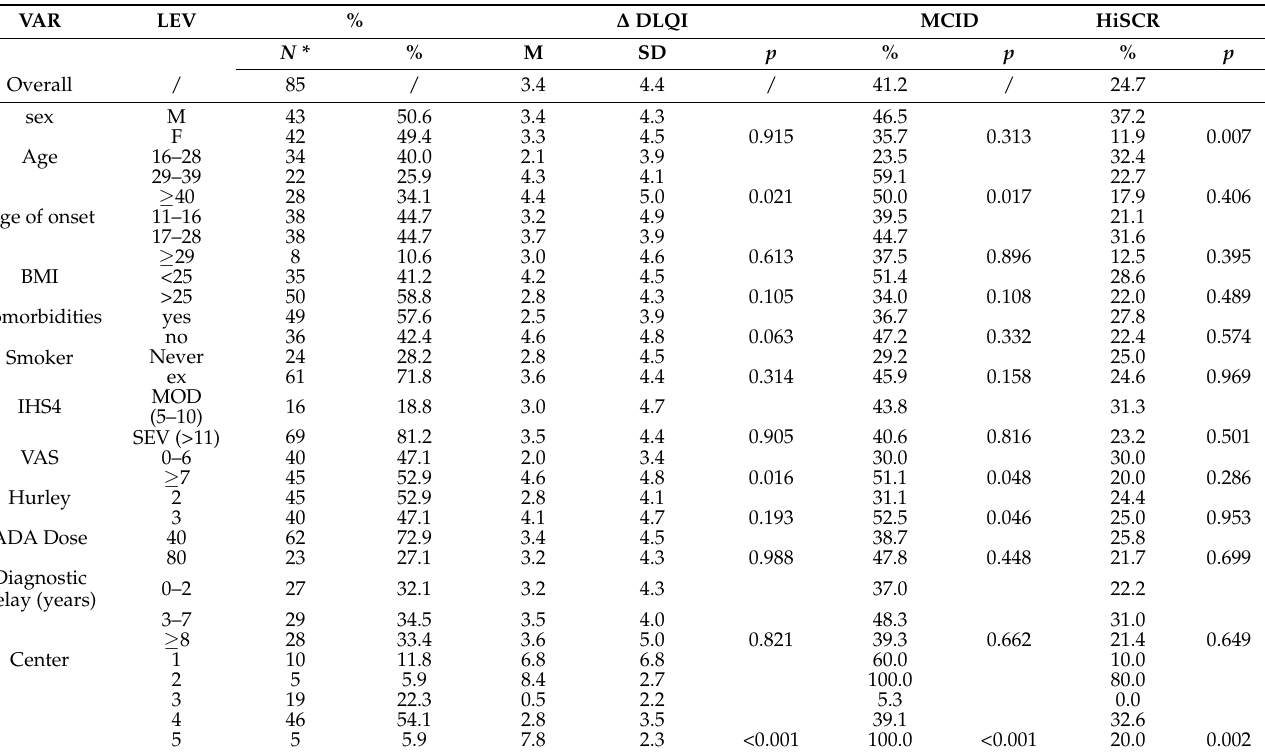
Table 1. Sociodemographic and clinical features of the sample at baseline. Quality of life and clinical differences at T32 for the baseline variables of